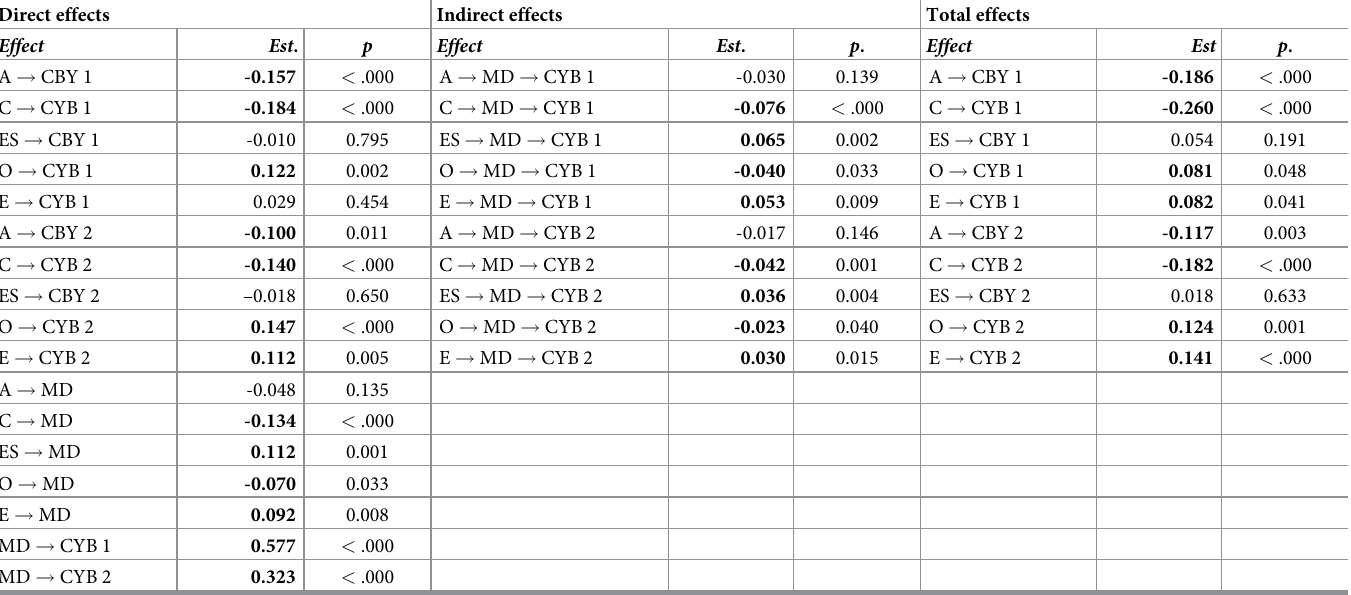
Table 7. Results of the mediation analysis from the structural equation modelling